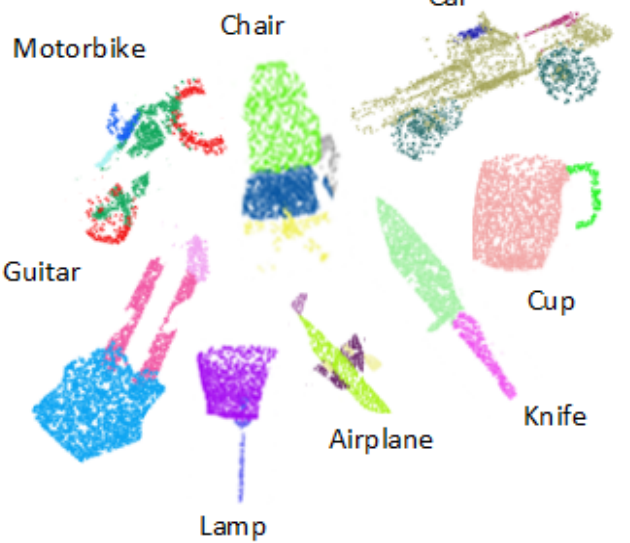
Figure 7. Qualitatively the result is visualized with 16 different object categories, shows that our network performs state-of-the-art in the partial input